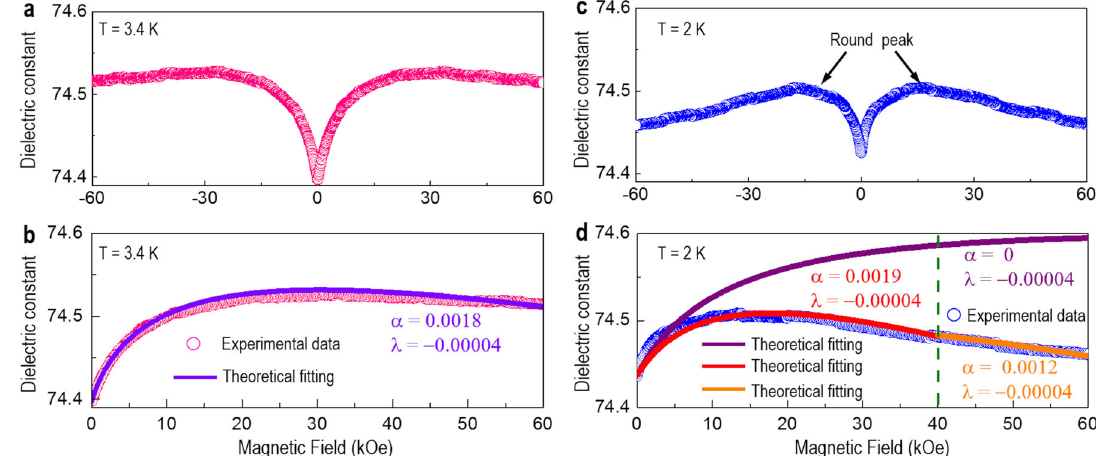
Fig. 6 Magnetodielectric coupling of an ETO:MgO VAN fi lm. Magnetic fi eld-dependent dielectric constant measured at 3.4 K ( a ) and 2 K ( c ). Comparison of the theoretical results with the experimental data of the magnetic fi eld-dependent dielectric constant at 3.4 K ( b ) and 2 K ( d ). The open circles represent the experimental data, while the solid lines represent the theoretical results with different parameters. λ is the biquadratic spin – phonon coupling coef fi cient and α is the corresponding coef fi cient to scale the strength of the tuning effect of the magnetic fi eld on the lattice